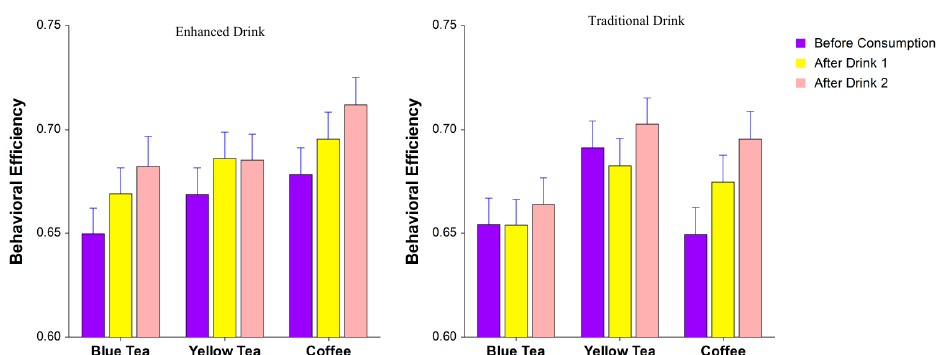
Figure 6. Stroop behavioral e ffi ciency. The left graph indicates behavioral e ffi ciency while participants consumed the enhanced drink. The right graph indicates behavioral e ffi ciency while participants consumed the traditional drink. Whiskers represent the SEM.